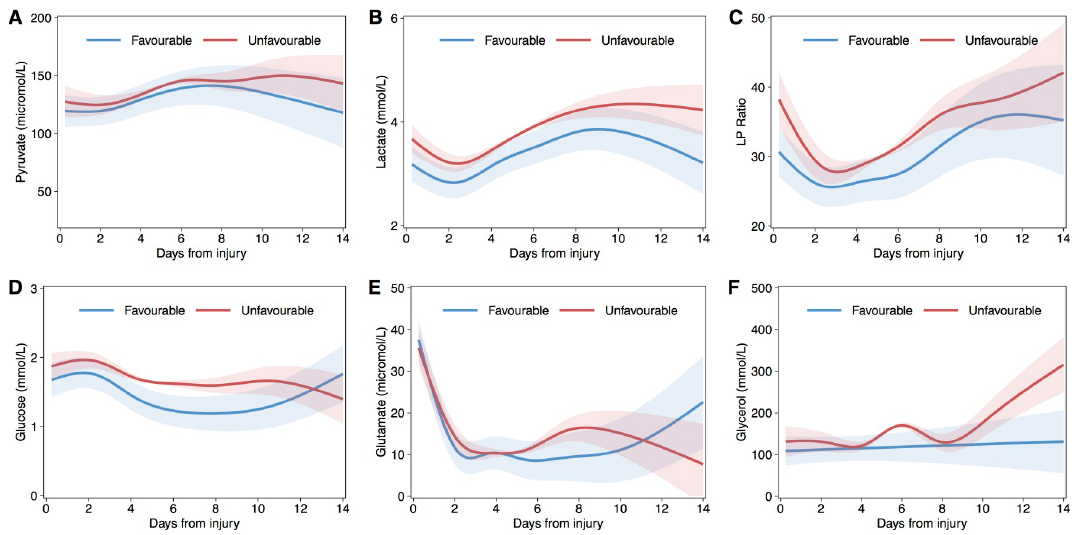
Fig 2. Fitted population mean time courses for microdialysis analytes using Generalised Additive Mixed Models (GAMM), by dichotomised glasgow outcome score group. Lactate (A), Pyruvate (B), Lactate-Pyruvate Ratio (LPR, C), Glucose (D), Glutamate (E), and Glycerol (F). Shaded areas indicated 95% confidence intervals.